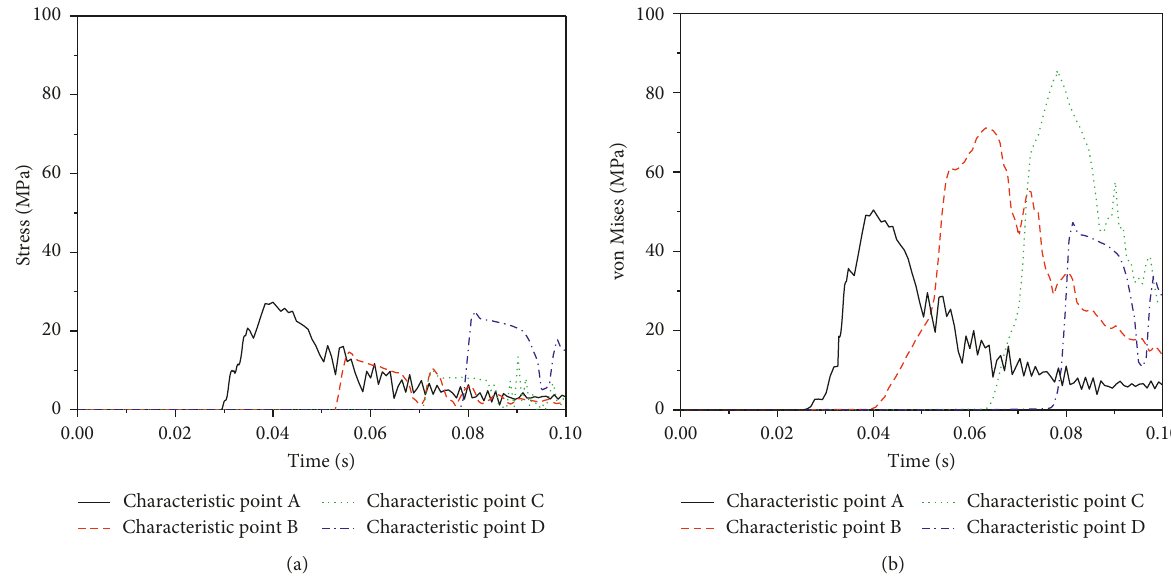
Figure 11: Stress curves of the characteristic points. (a) Circumferential stress. (b) von Mises